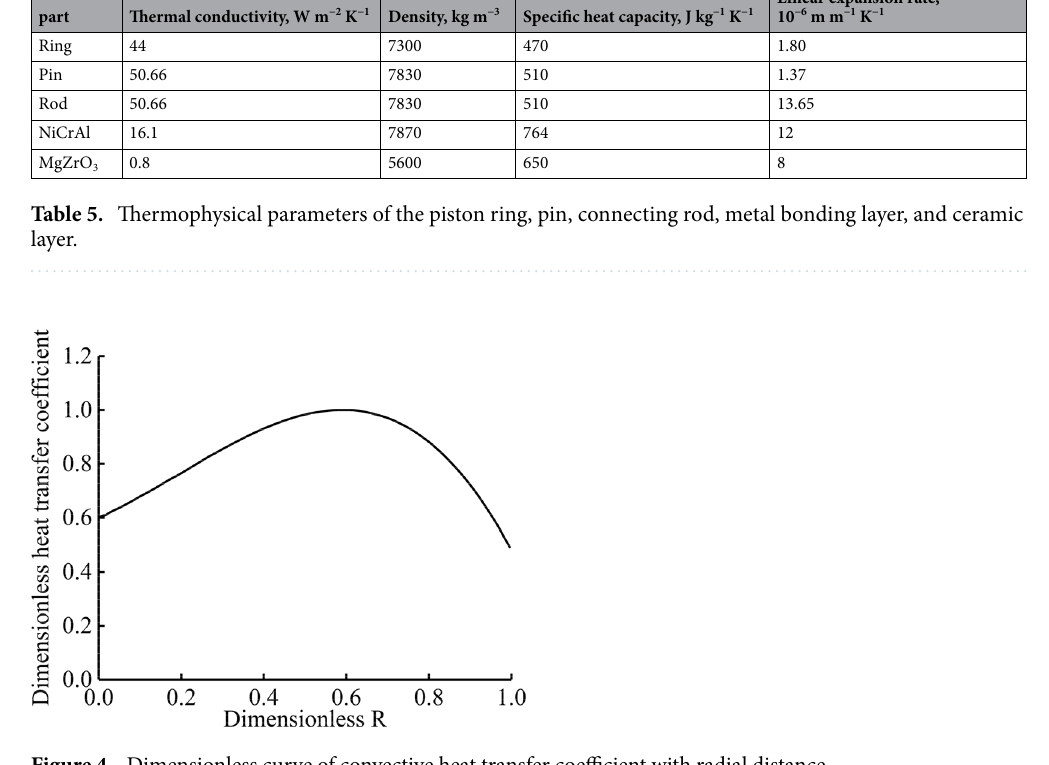
Figure 4. Dimensionless curve of convective heat transfer coefficient with radial